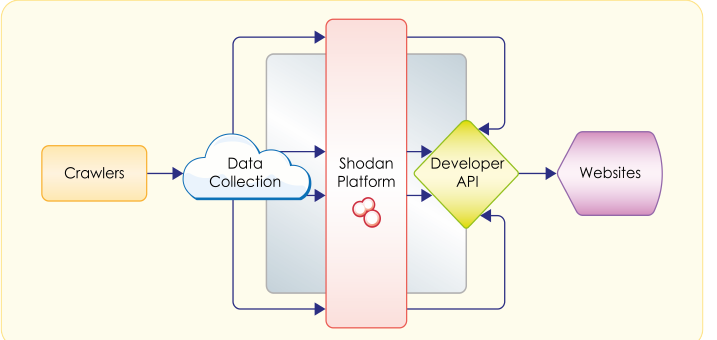
Figure 5. High-level diagram showing the flow of data in the Shodan platform [21]. Shodan’s